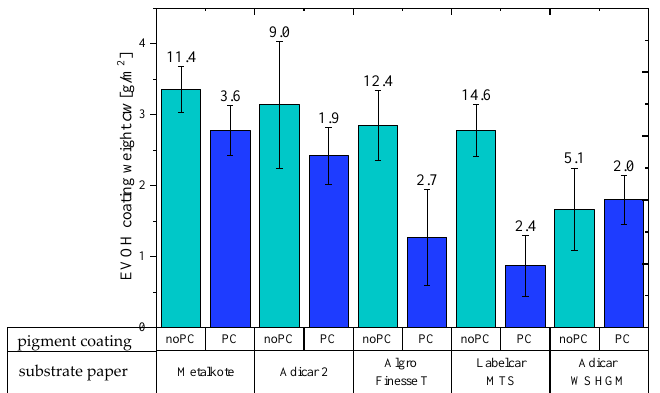
Figure 2. Coating weight at 50% relative humidity. Although in each case the same EVOH coating and the same rod was used, the weight of the EVOH coating was higher on the rougher noPC surface. Roughness values R Z before EVOH coating are shown as numbers above the columns. PC/noPC = paper surface with/without pigment coating. EVOH = ethylene vinyl alcohol lacquer.